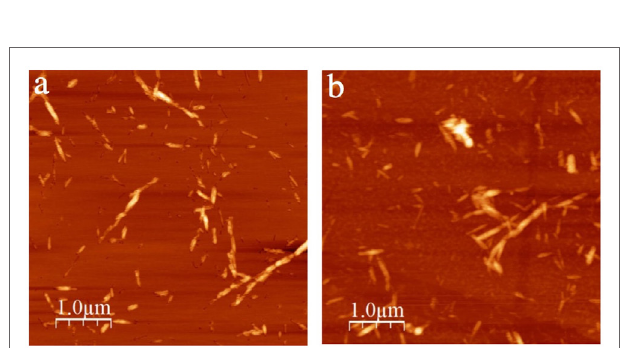
FigUre 5 | Phase separation of l-cnc suspensions with w = 9 wt.- %, at different concentrations c s of added nacl . The fraction of the bottom phase is reduced by salt addition, but the difference in appearance of the two phases also gets increasingly